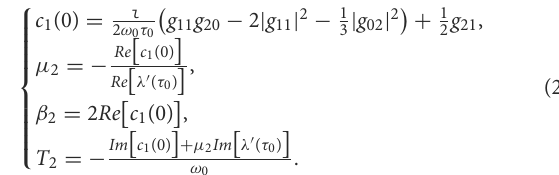
1, b 1, c 2, d 1, I 0.7, D u = = = = =